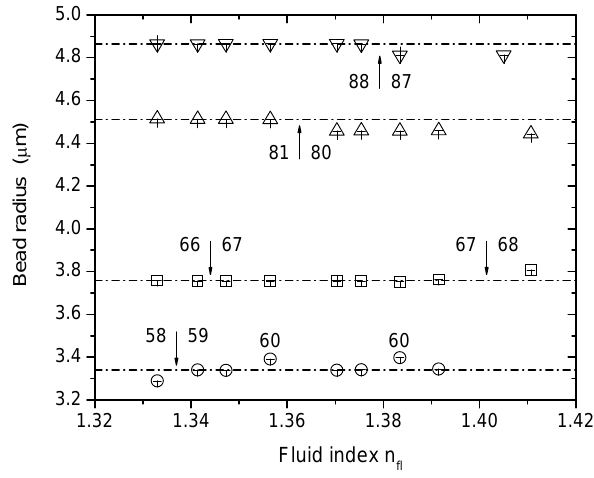
Figure 6. Bead radii of the different beads studied in dependence of the fluid index, n the DI water/glycerol mixture injected into the microfluidic flow cell as determined by the fitting procedure. The arrows indicate a step up or down of the corresponding mode errors calculated from a variation of Equation 2. numbers. The errors shown are the   10% For details, see main